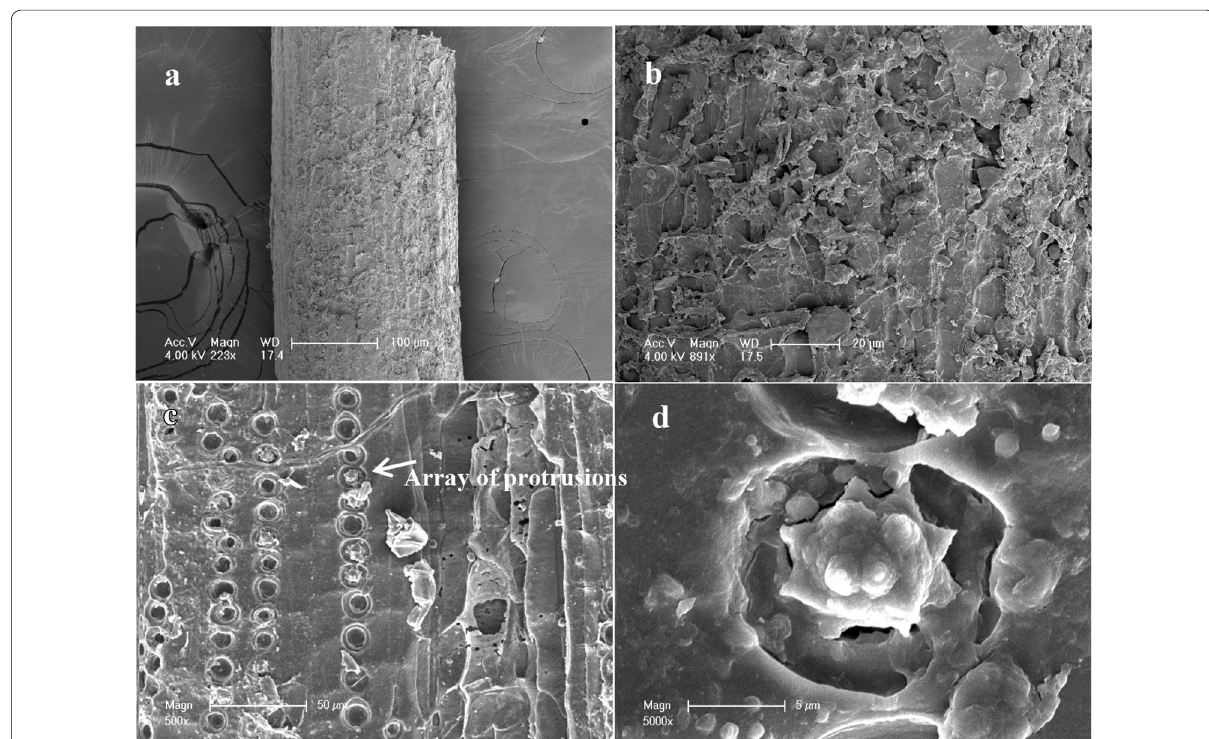
Fig. 3 Surface morphological characterizations of palm fibers in outer layer: a sub-cylindrical shape, b waxy and course surface, c arrays of protrusions embedded with d silica